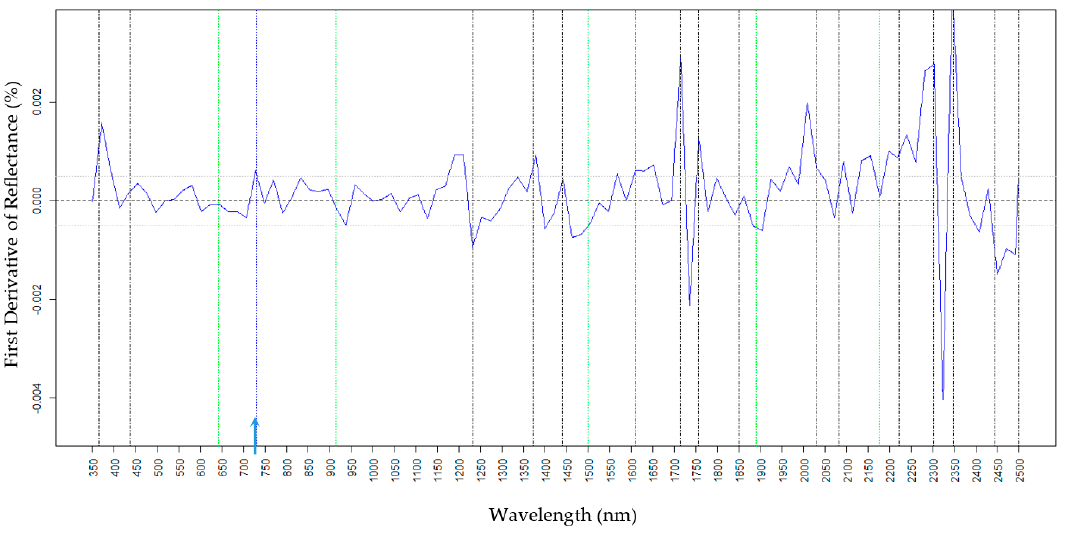
Figure 3. First derivative reflectance of the pure Triacontanol-1. Black vertical lines indicate absorption features common with H16 and Octacosanol-1. Green lines indicate absorption features unique to Octacosanol-1 and blue lines depicted with a blue arrow on the base are Triacontanol-1 specific.